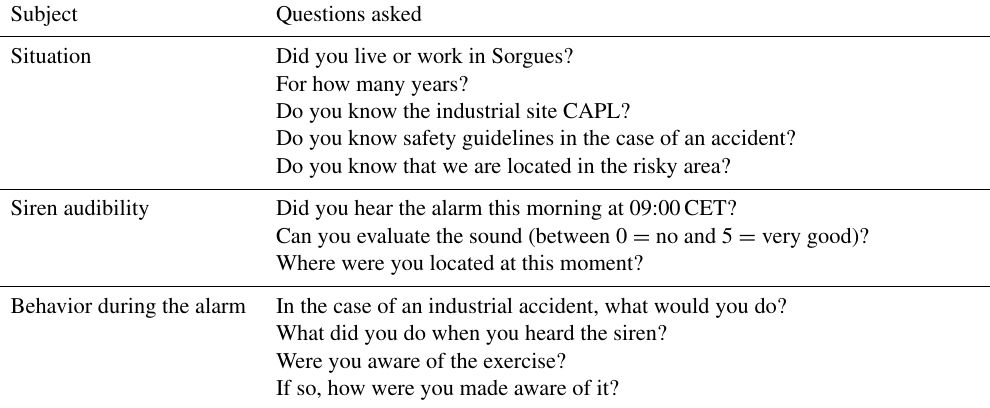
Table C1. Questions included in the face-to-face survey, asked to 280 people living in an industrial risk area during an emergency manage- ment exercise in